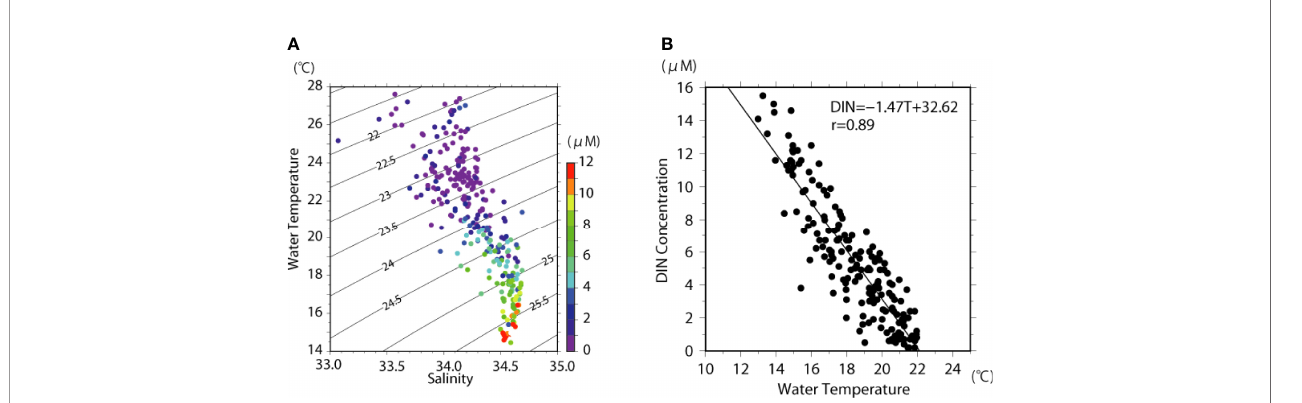
FIGURE 12 | (A) T-S diagram with dissolved inorganic nitrogen (DIN) concentration observed in the southern part of the Bungo Channel. Observation points are shown as triangles in Figure 1B . (B) Scatterplot of water temperature and DIN observed in the southern part of the Bungo Channel. The line in the fi gure is the regression line.